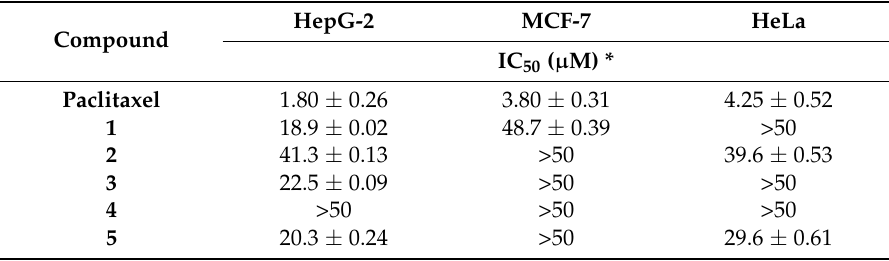
Table 3. IC 50 values of compounds 1 – 5 against HepG-2, MCF-7, and